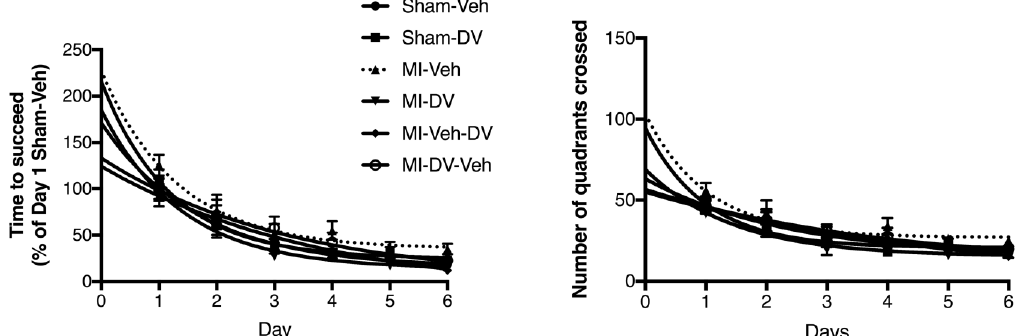
Figure 4. Morris Water Maze test. Left panel: Time needed to reach the target platform expressed as a percentage of time needed by sham rats treated with the vehicle. Right panel: Total number of quadrants crossed (6 trials per day) before finding the target platform. The dotted lines with triangle markers represent the results obtained by vehicle-treated MI rats. When tested 4 months after surgery, vehicle-treated MI rats took more time to find the platform and crossed more quadrants to find the platform compared to any of the other groups; n = 9–12 per group. (* p < 0.05). The performance of the MI rats treated with DV was the same as that of the vehicle-treated sham rats. MI: myocardial infarction; Veh: vehicle; DV: Desvenlafaxine.